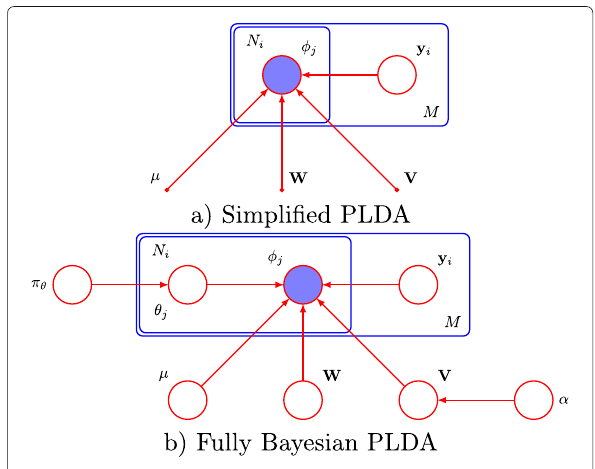
Fig. 6 Bayesian network of the employed PLDAs. a Simplified PLDA. b Fully Bayesian